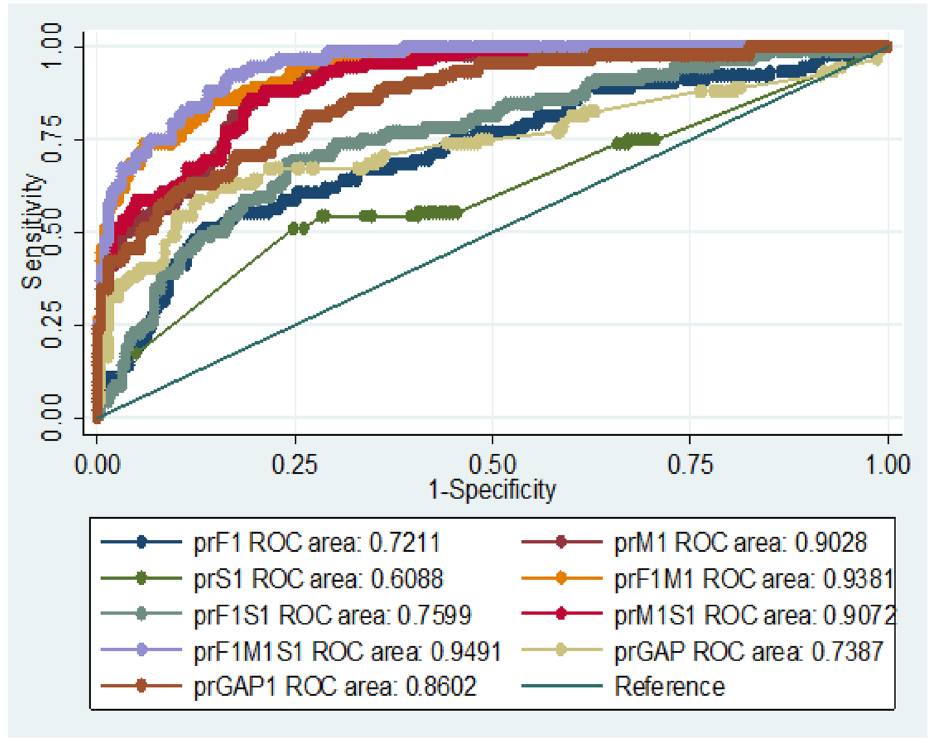
Figure 1. Assessing discrimination ability of nine different models on intrapartum stillbirth: ROC Receiver Operating Characteristics Curve; prF1 Only Fetal factors; prM1 Only Maternal factors; prS1 Only Service factors; prF1M1 Fetal + Maternal factors; prM1S1 Maternal + Service factors; prF1M1S1 Fetal + Maternal + Service factors; prGAP Gestational age + antepartum Hemorrhage + pregnancy induced hypertension + pre-rapture membrane; prGAP1 Gestational age + antepartum Hemorrhage + pregnancy induced hypertension + pre-rapture membrane + Hemoglobin at registration + Weight at registration + Intermittent Preventive Treatment for pregnant